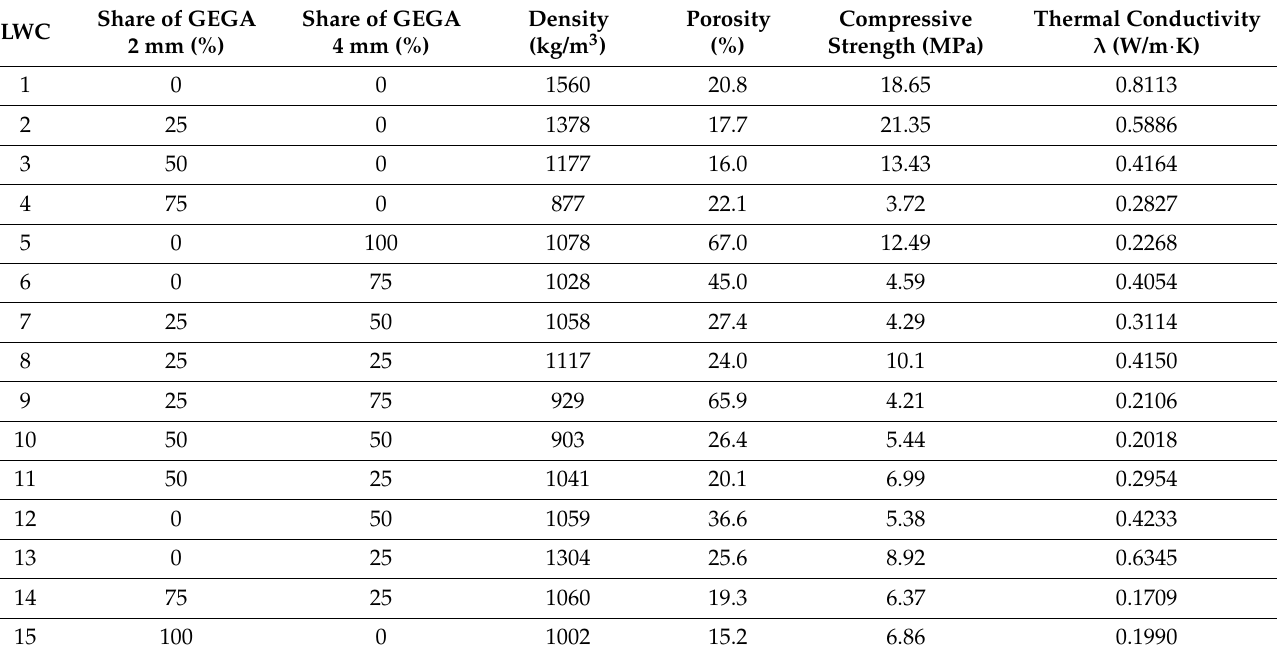
Table 4. The LWC laboratory test